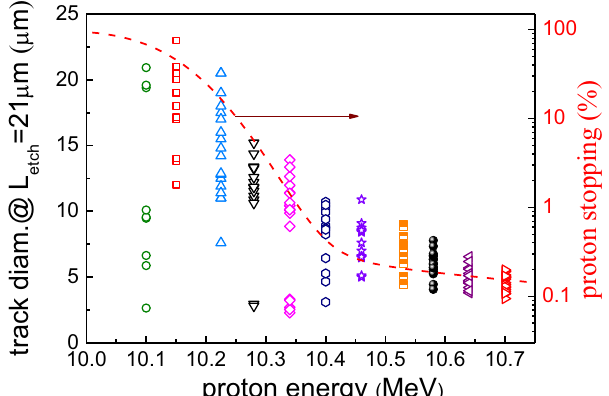
Figure 7. Track diameter distribution of protons in transparency regime. Track diameter and percentage of proton stopped in 1 mm thickness of CR-39, calculated by SRIM. Protons are partially transparent in the energy range of (10–10.4) MeV. The huge distribution for the track diameter implies longitudinal range straggling. The average track diameter and their distribution decrease after 10.4